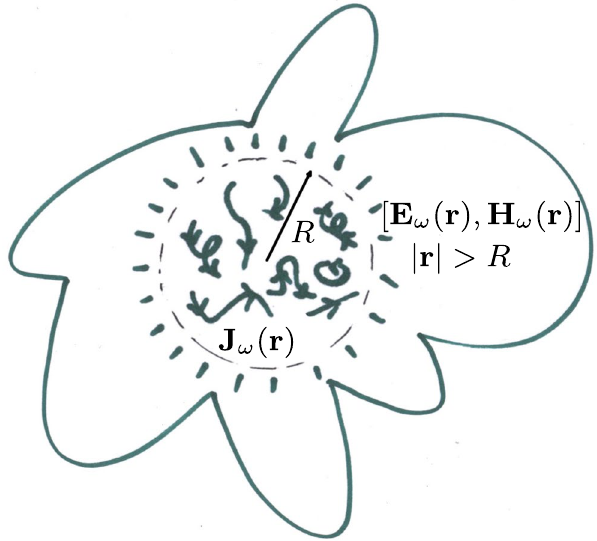
Figure 1. The monochromatic electric current density distribution J ω ( r ) is confined to a sphere of radius R : The source region . In this article, we consider the electromagnetic fields produced by the source outside its region, i.e. [ E ω ( r ), H ω ( r )] for | r | > R . These fields are completely determined by the Fourier components of the current density which meet | p | = ω / c (see Fig. 2). The other components do not produce fields outside the source